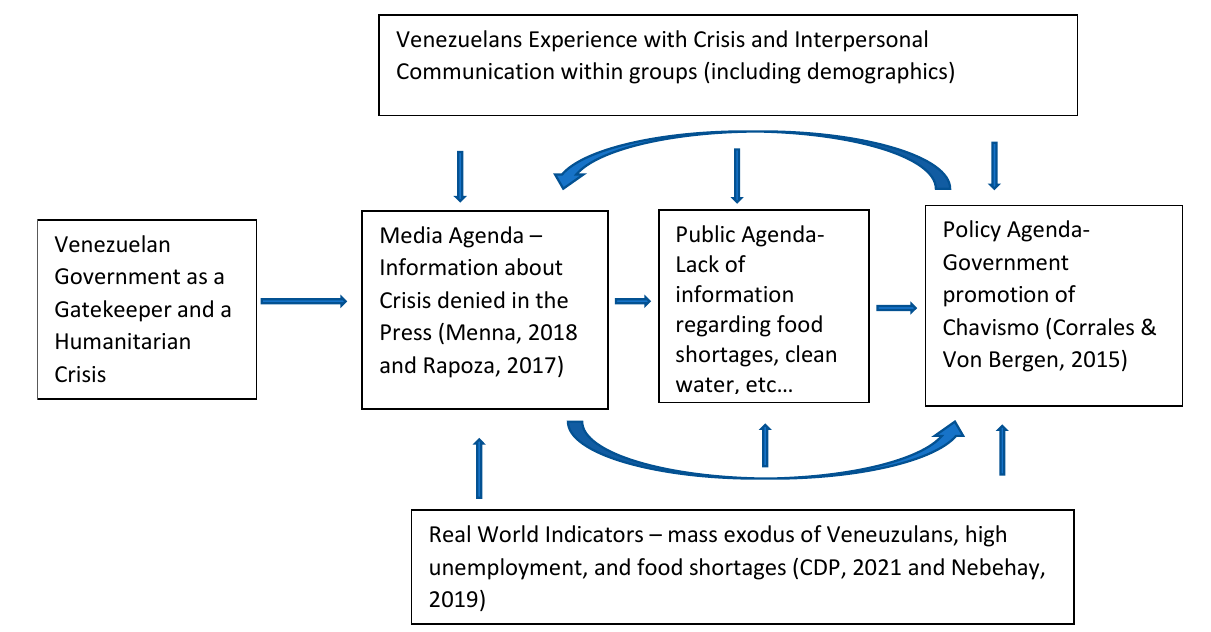
Figure 6. Venezuelan Case of Agenda Setting. (CDP 2021; Corrales and Von Bergen 2015; McCarthy 2017; Menna 2018; Mores and Georgacopoulos 2020; Nebehay 2019; Rapoza 2017; Venezuelan Humanitarian and Refugee Crisis 2021).